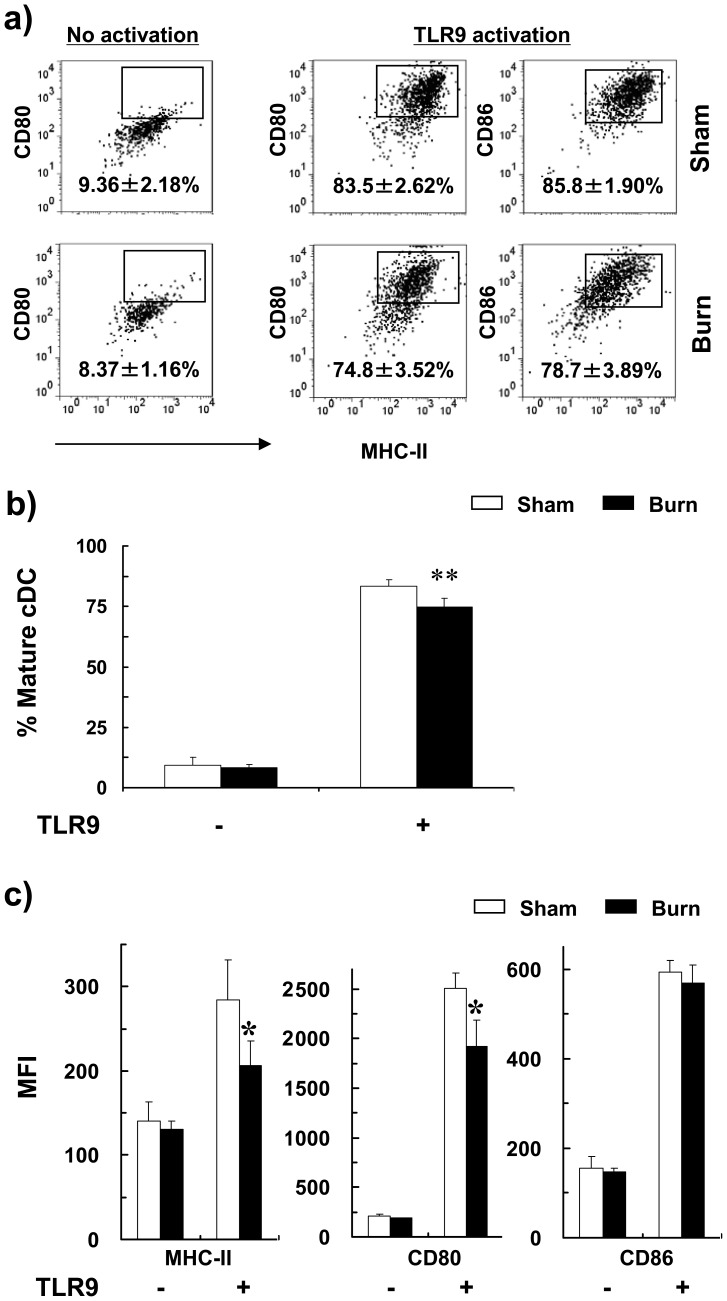
Burn injury impaired TLR9-induced cDC maturation.Three days post-injury, total splenic CD11c+ DCs were activated with or without CpG (24 hr) and stained for CD11c, B220, CD80, CD86 and MHC II. CDCs were gated as CD11chiB220− and the expression of CD80, CD86 and MHC II were analyzed by flow cytometry. (a) Representative FACS plots of non-activated (left) and TLR9-activated (right) cDCs of burn and sham mice. Percentages of mature cDCs (MHCIIhiCD80hiCD86hi) are shown as mean ± SEM (n = 9, 3 independent experiments). (b) Percentages of MHCIIhiCD80hiCD86hi mature cDCs and (c) mean fluorescence intensity (MFI) of MHC-II, CD80 and CD86 expression on cDCs with and without TLR9 activation are shown as mean ± SEM (n = 9, 3 independent experiments). *P<0.05; **p<0.01, sham versus burn by ANOVA.